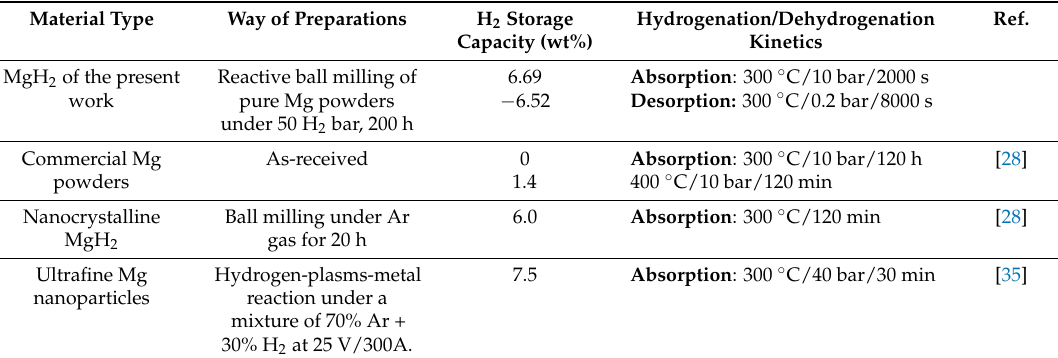
Table 3. Hydrogen storage properties for different types of MgH 2 powder.